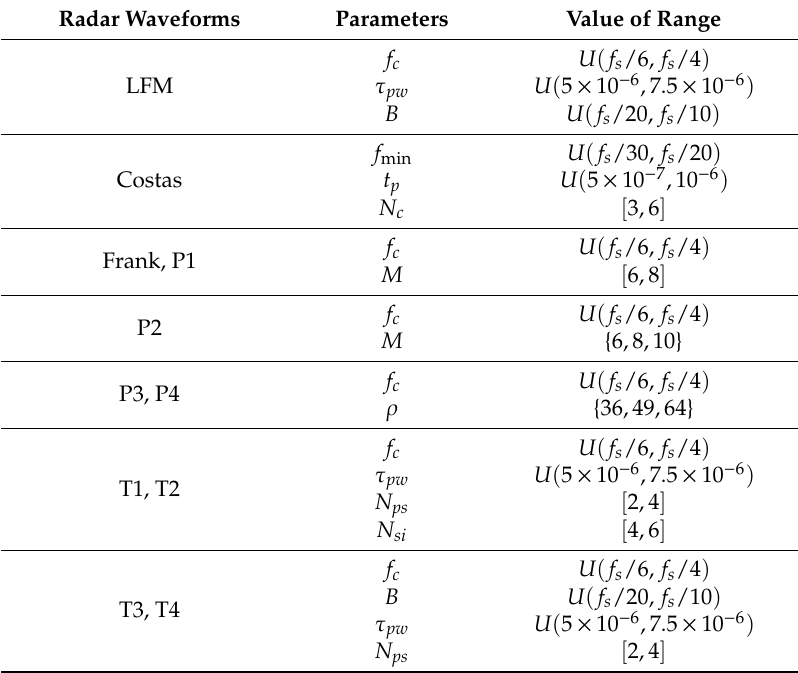
Table 3. The range of signal parameter